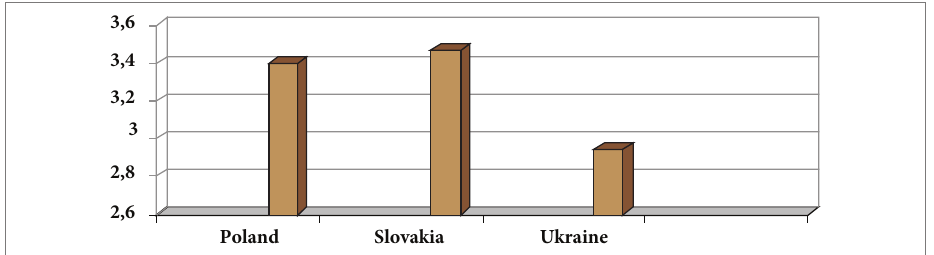
Fig. 17. The level of partnering relations of construction enterprises in the selected regions of three